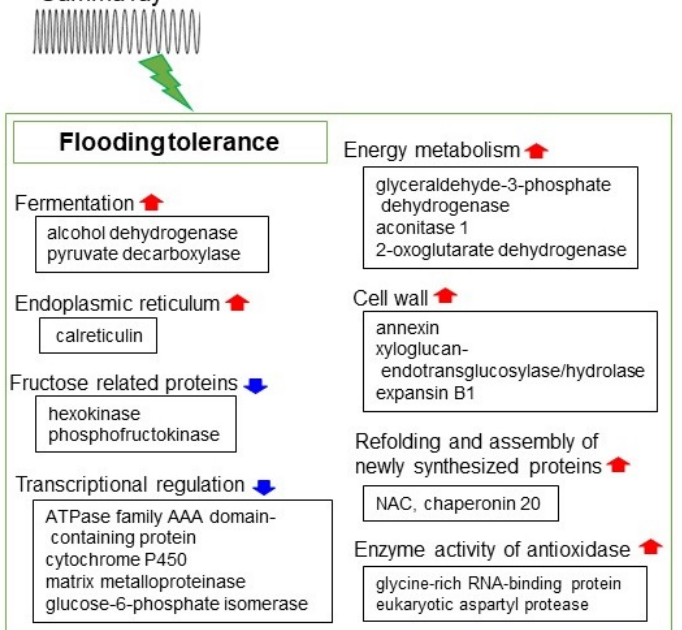
Figure 3. Summarizing overview of gamma irradiation-induced flooding tolerance in soybean. The upward red arrows mean activated metabolisms or increased proteins, while downward blue arrows mean suppressed metabolisms or decreased proteins.